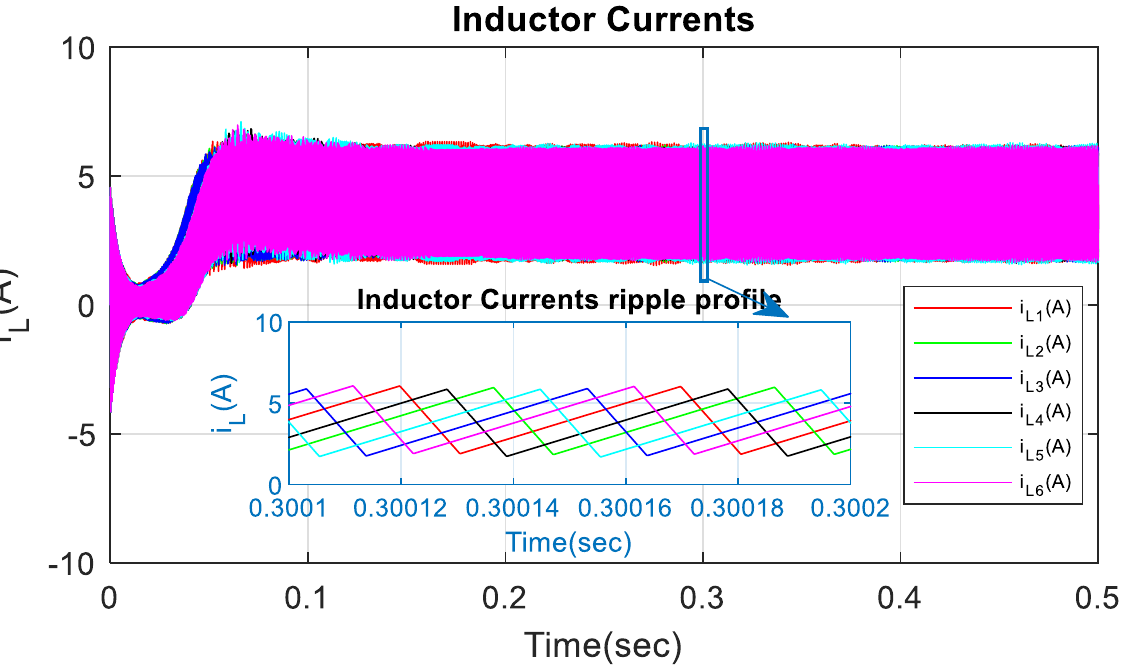
Figure 11. Experimental waveforms of the inductor currents in six phases.